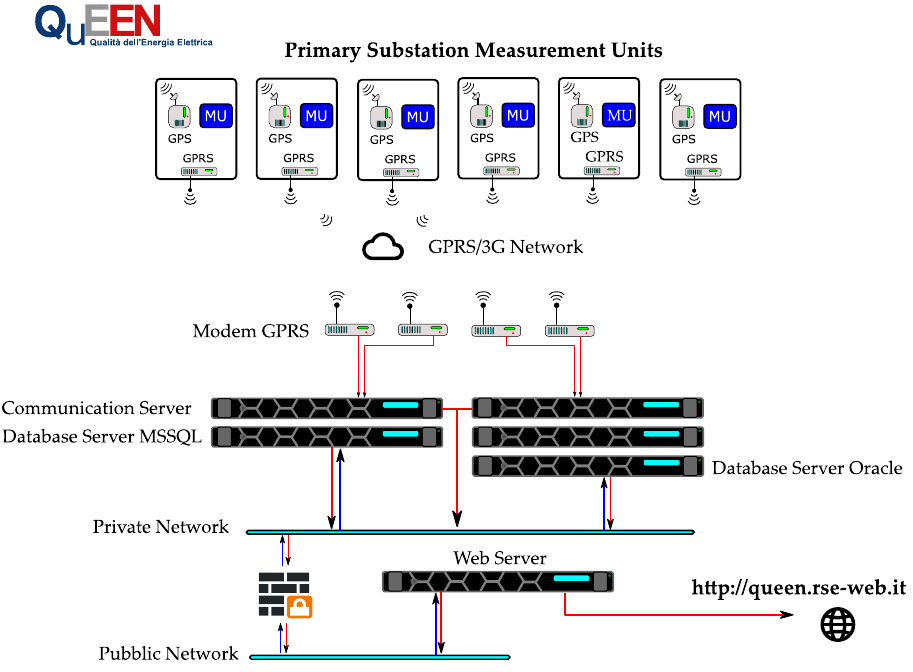
Figure 1. QuEEN system architecture .